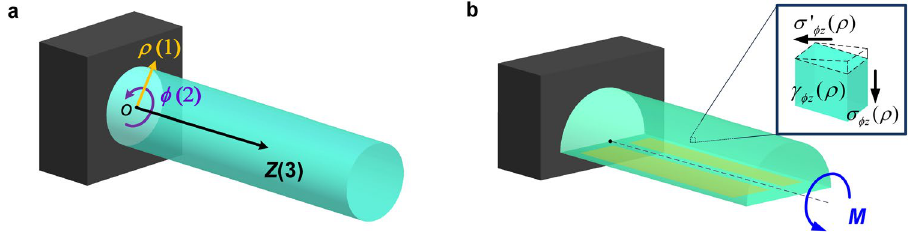
Figure 1. ( a ) The coordinate definition presented in this work. ( b ) The strain gradient generating method of the half cylindrical shaped specimen with the electrode